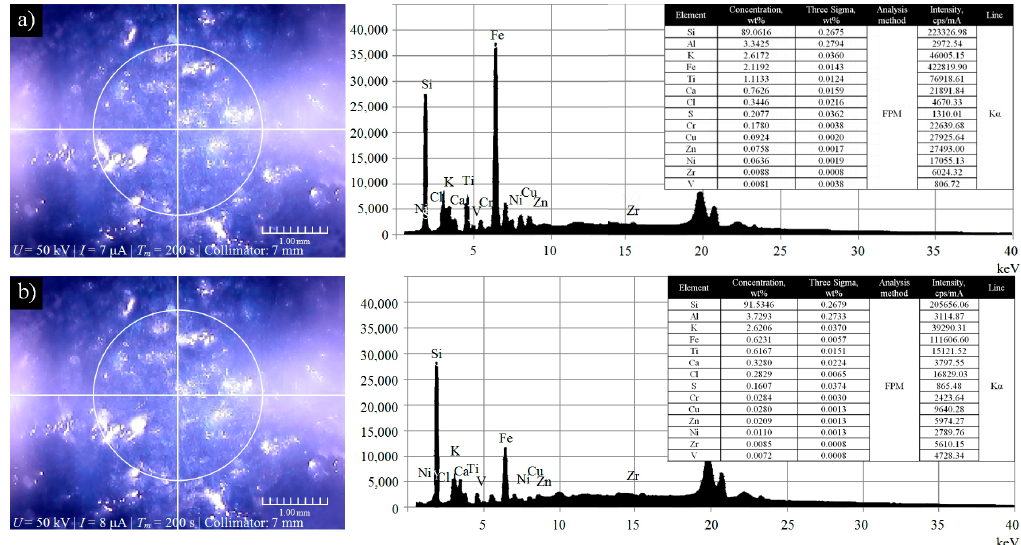
Figure 4. Elemental microanalysis of correctness of introduction of the synthetic organosilicon polymer-based impregnate (silicone) into the active surface of small-size grinding wheel 1-35×10×10 SG/F46G10VTO carried out by the use of X-ray fluorescence analyzer Horiba Mesa 50: ( a ) imaging of analyzed area (Area 1) of the SGTW-2 ( left ), spectrogram and obtained results of elemental microanalysis ( right ); ( b ) imaging of analyzed area (Area 2) of the SGTW-2 ( left ), spectrogram and obtained results of elemental microanalysis ( right ).